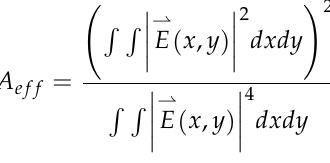
Table 2. The highest confinement loss (dB/m) for the proposed terahertz OAM